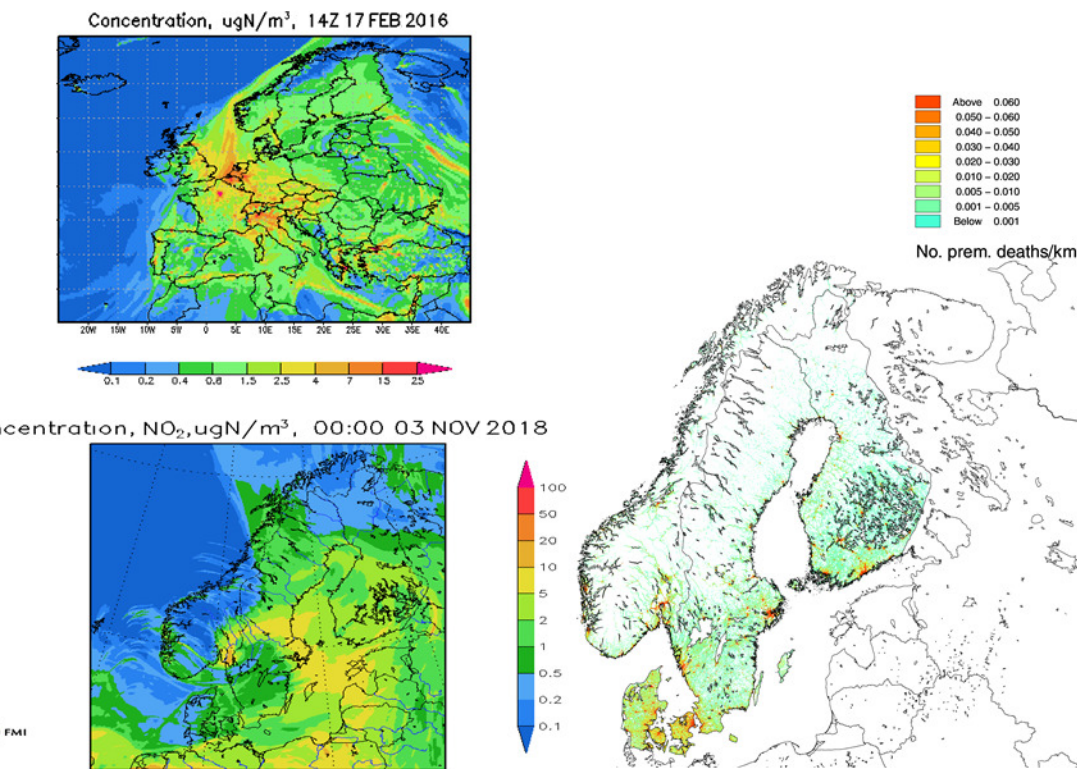
Figure 16. An illustration of how concentration predictions at a high spatial and temporal resolution (panels on the left-hand side) could be used for high-resolution health impact assessments (panel on the right-hand side). The concentration distributions were predicted with the chemical transport model SILAM. The health impact assessment was made with the EVA model in a high-resolution setup for the Nordic region, giving an estimate of the number of premature deaths due to exposure to air pollution (Lehtomäki et al., 2020). The concentrations used in EVA were from the chemical transport system DEHH-UBM, providing 1km × 1km concentration across the Nordic